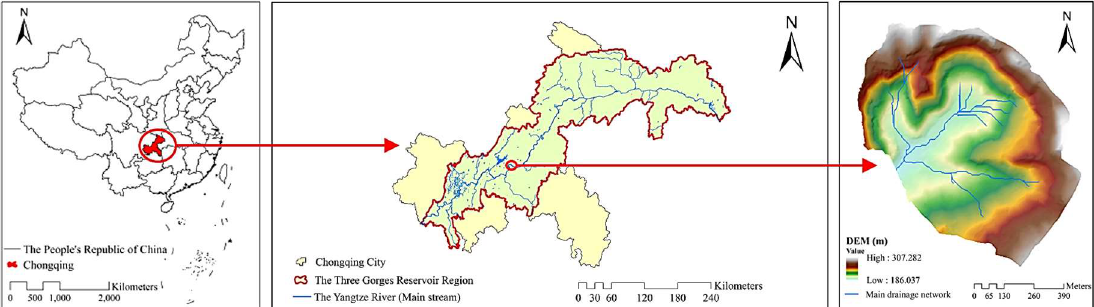
Figure 1. The sketch map of the Wangjiagou agricultural watershed.